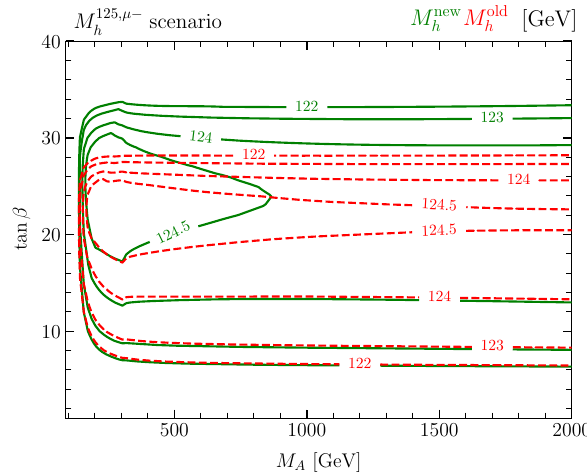
,μ − scenario using a h